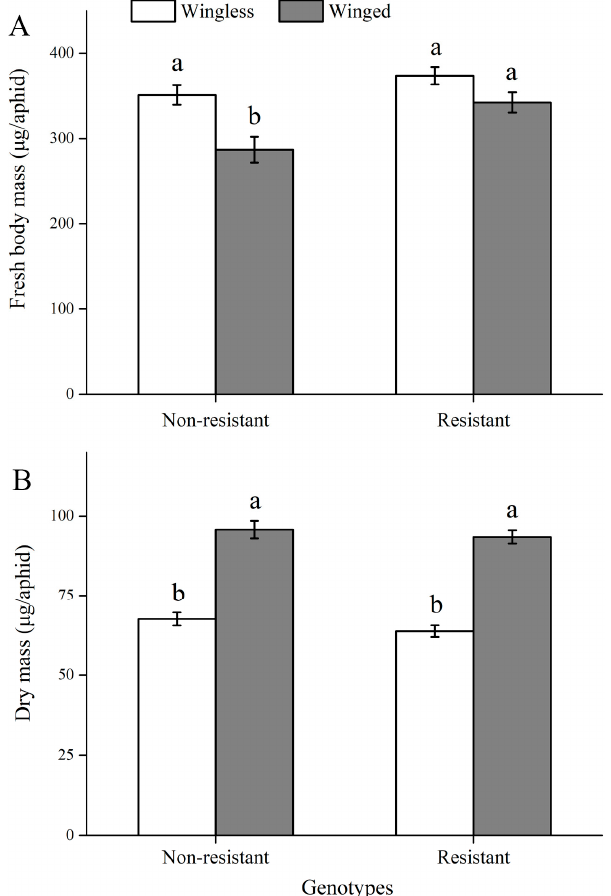
Figure 1. Comparisons between nonresistant and resistant genotypes for body mass (mean ± SE) of winged and wingless S. avenae : ( A ) fresh body mass; ( B ) dry mass; different letters above bars indicate significant differences between treatments).